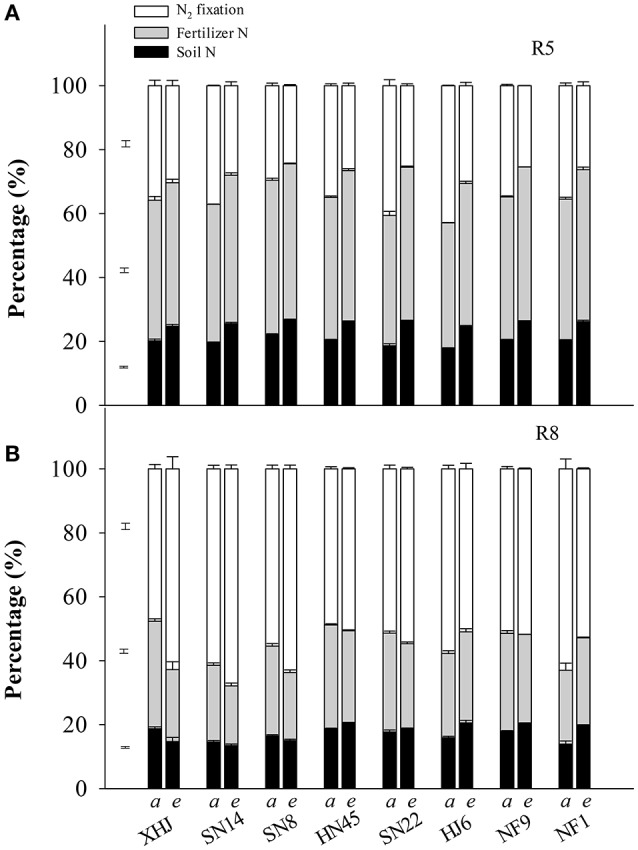
The effect of CO2 on the percentage of plant N derived from symbiotically fixed-, fertilizer-, and soil-N at (A) R5 and (B) R8 (81 and 120 days after sowing, respectively). The error bars represent standard error, and separate vertical bars indicate the LSD (P < 0.05) for the CO2 × cultivar interaction. The letters of a and e on the x-axis indicate aCO2 and eCO2, respectively.